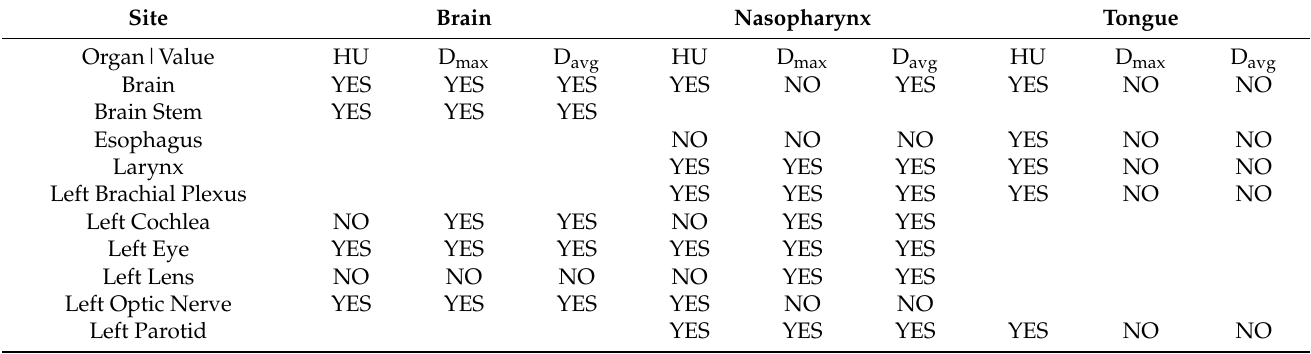
Table 3. Summary of statistical analysis results for critical structures in brain and head and neck. “YES” indicates statistically significant difference in CT number (HU), maximum dose (D max ), and mean dose (D avg ) values between NCCT and CCT images, and “NO” is vice versa.